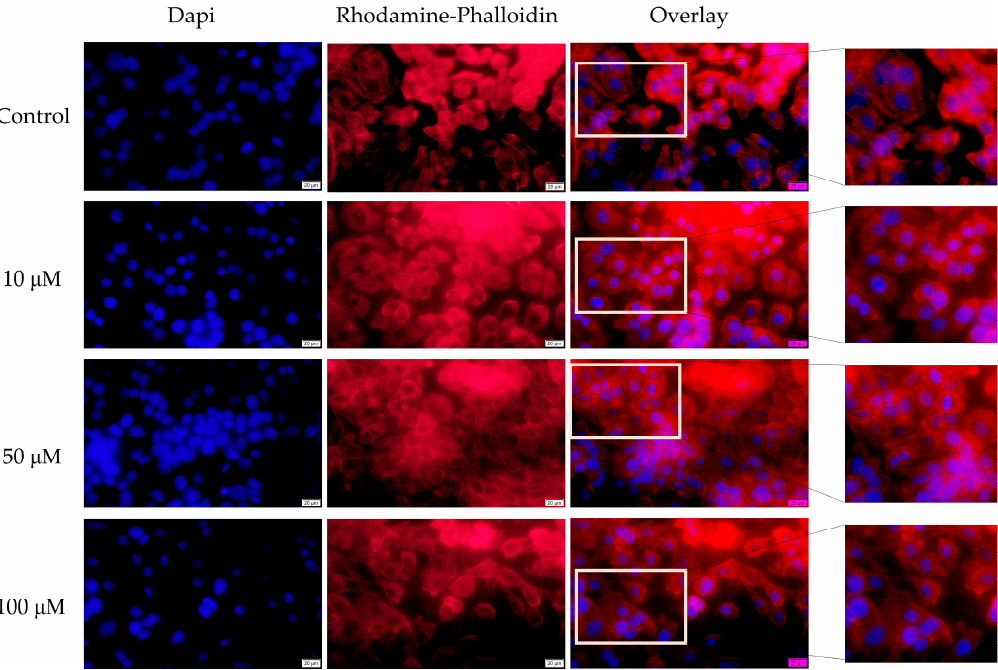
Figure 7. The impact of ampicillin (10, 50, and 100 μ M) after 72 h at the level of: nuclei—DAPI staining (blue) and F-actin fibers—Rhodamine Phalloidin (red). The pictures were taken using a 40× objective at a scale bar of 10 μ m.